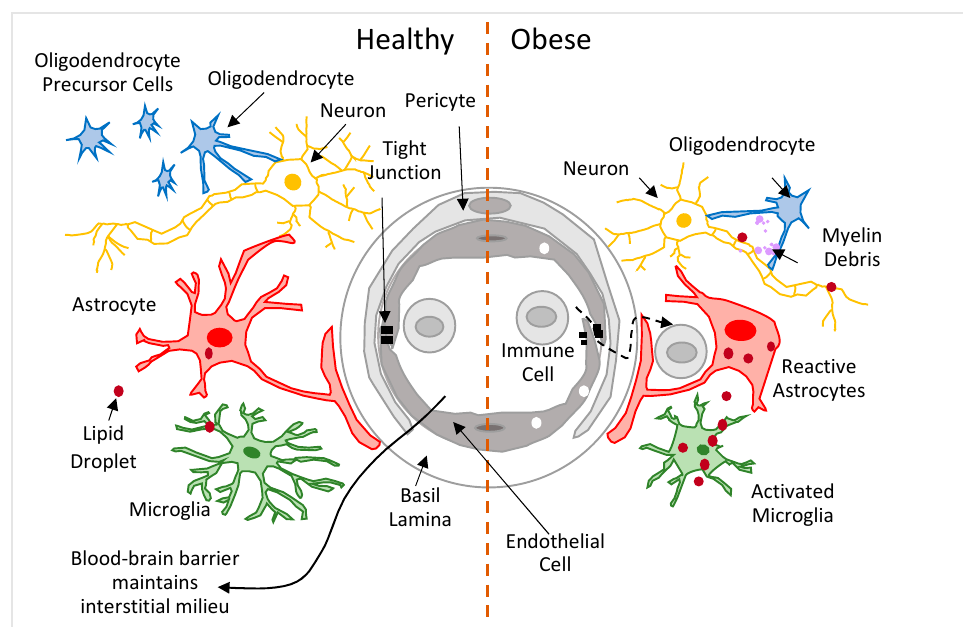
Figure 2. Schematic of cellular composition of brain tissue in healthy and obese brains.